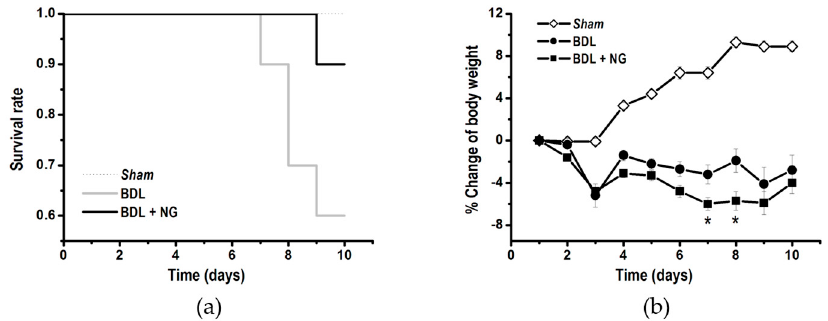
Figure 5. Survival rate ( a ), and percentage change of body weight ( b ) measured after administration of naringenin (NG, 50 mg/kg/day) for 10 days. *Significantly different from bile duct-ligated (BDL) group at p < 0.05 ( n = 10 animals/group).